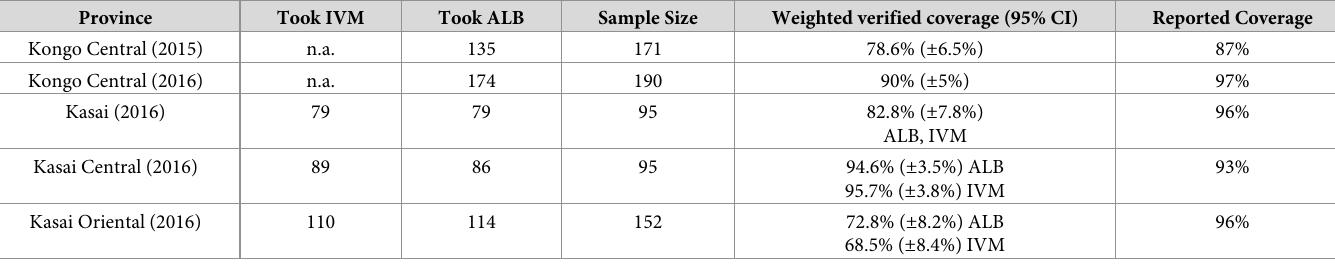
main reason for not taking ALB (50%), fear of adverse effects was reduced to 13%, due to improvements in provincial and district supervision, social mobilisation and the lack of serious adverse effects in the previous year. Table 3. DRC verified coverage of Ivermectin and Albendazole by province in 2015 and 2016 � .